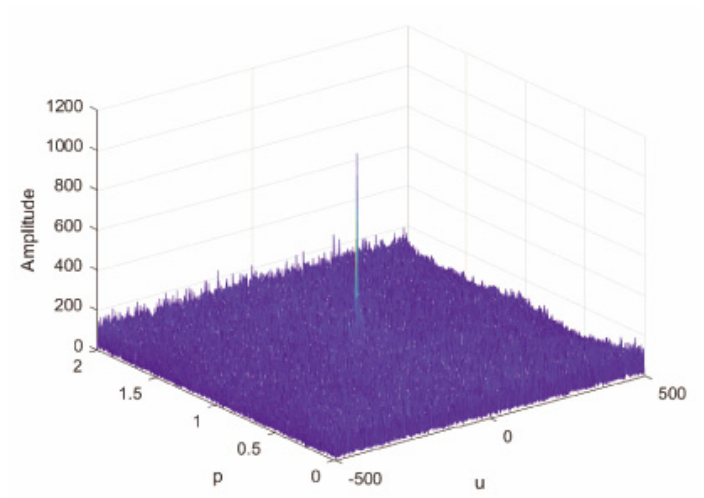
Figure 8. Fractional Fourier transform (FrFT) result of the 33rd range cell.